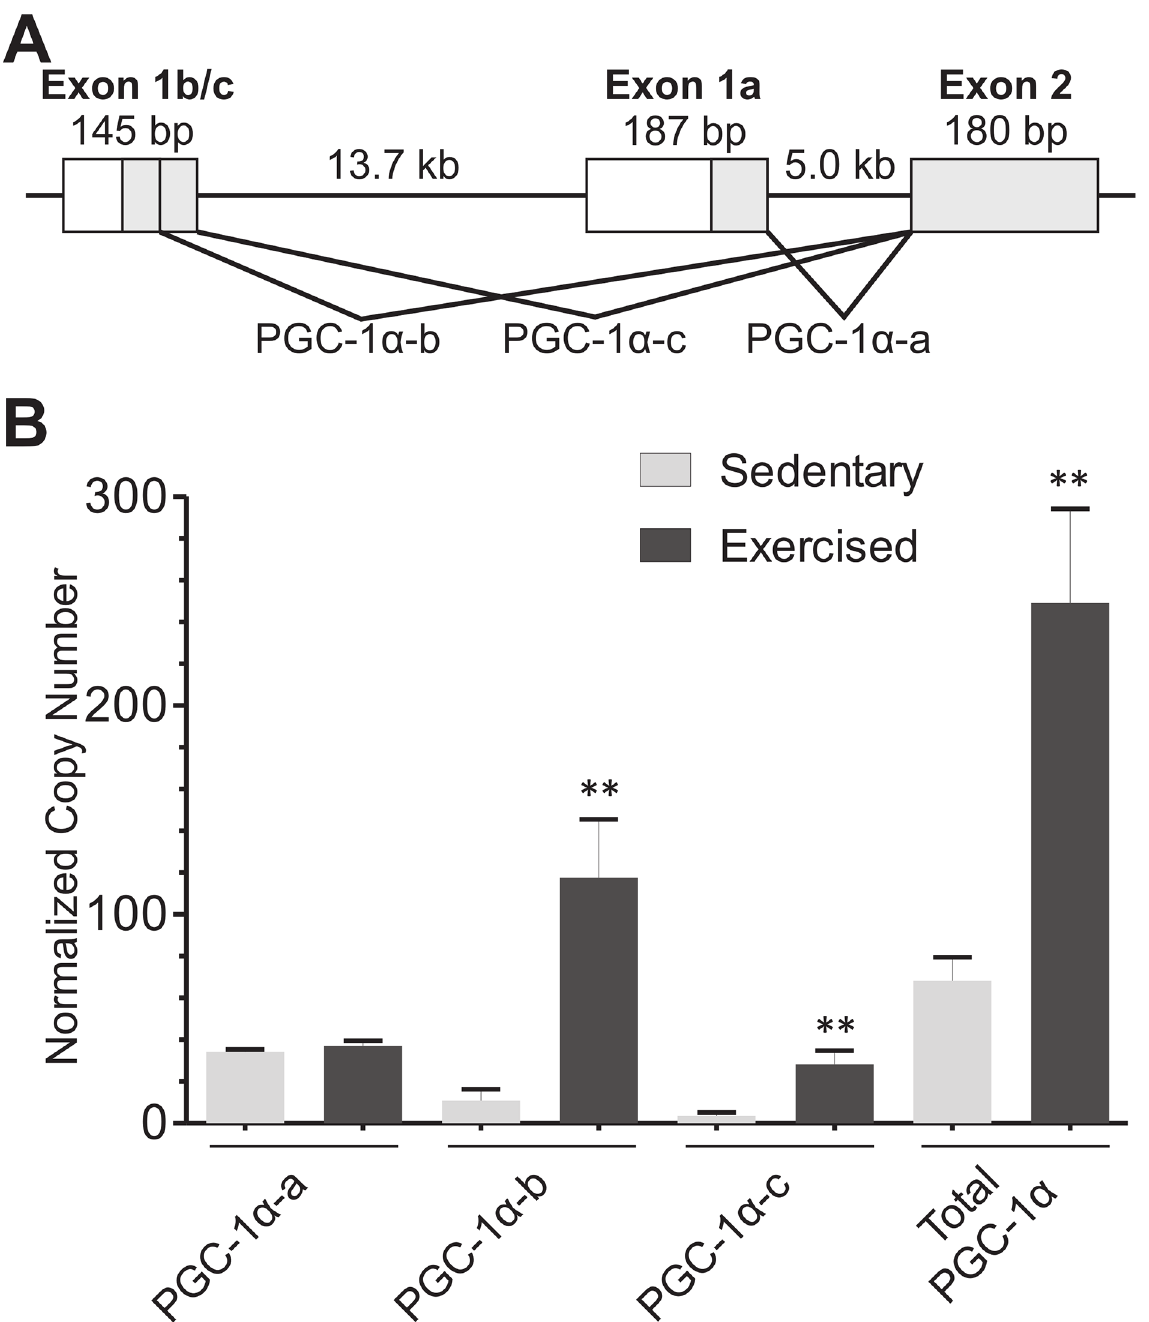
Fig 2. PGC-1 α mRNA levels in skeletal muscle, by RT-qPCR, after rotarod exercise. (A) Schematic diagram of PGC-1 α isoforms examined in this study. PGC-1 α -a is expressed from one promoter, whereas PGC-1 α -b and PGC-1 α -c are both expressed from the same promoter. (B) Paired mice (n = 6 each group) were either exposed to rotarod exercise as described in Fig 1, or kept sedentary. RT-qPCR is shown for PGC1 α using isoform-specific primers against PGC-1 α -a, PGC-1 α -b, or PGC-1 α -c. Known quantities from separate cloned plasmids containing each isoform were used to quantitate absolute copy numbers of PGC-1 α isoforms or total PGC-1 α , which were normalized to geometric means of GAPDH and beta actin mRNA levels. Bars are shown ± SEM. ( ** p < 0.005 by paired t-test).